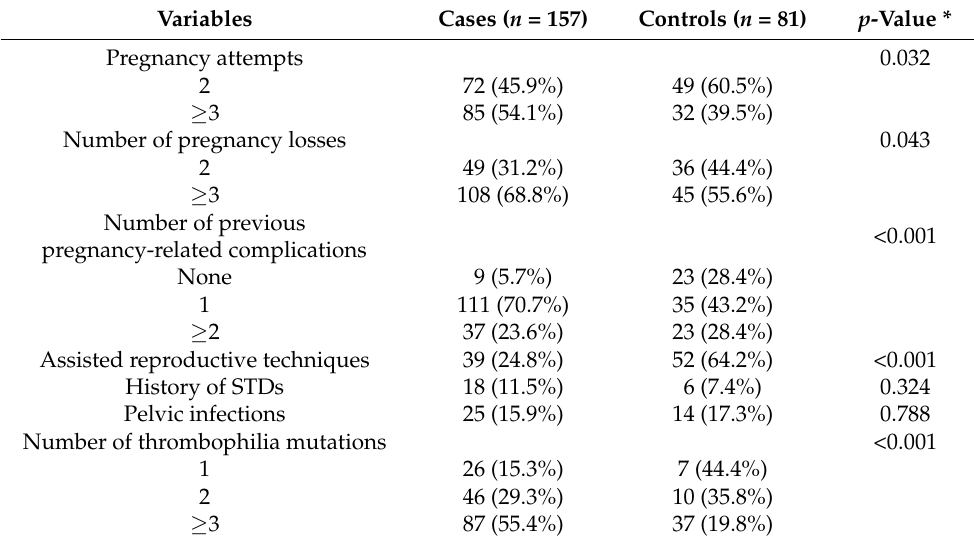
Table 2. Comparison of obstetrical characteristics between women with thrombophilia and recurrent pregnancy loss (cases), women with thrombophilia and recurrent pregnancy loss who achieved a normal pregnancy, and preterm or full-term birth (controls).